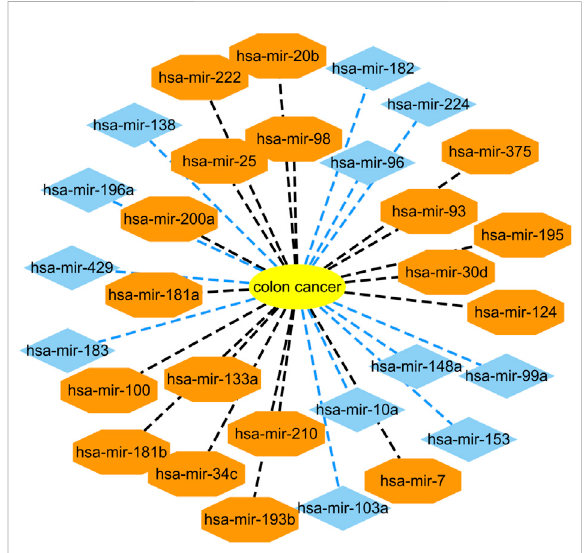
FIGURE 2 Associations between the predicted top 30 microRNAs and colorectal cancer except for known 129 microRNA-colorectal cancer associations in the HMDD database. Black dot lines denote associations between microRNAs and colorectal cancer and these associations have been reported by publications. Orange solidlinesdenoteassociationsbetweenmicroRNAsandcolorectal cancer and these associations are unknown and need to experimental